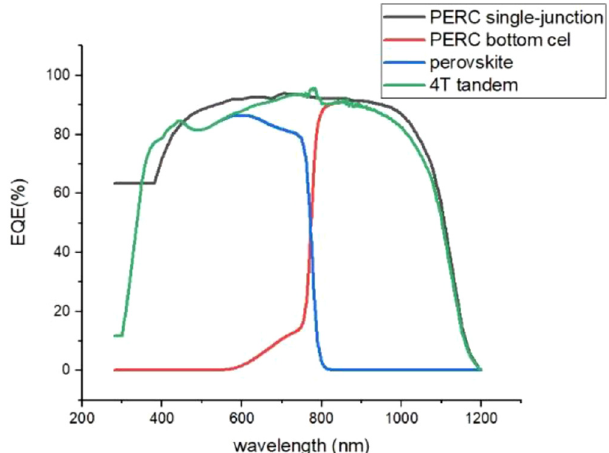
Fig. 4. External Quantum Ef fi ciency (EQE) graphs of the PERC and perovskite components, and their combination.